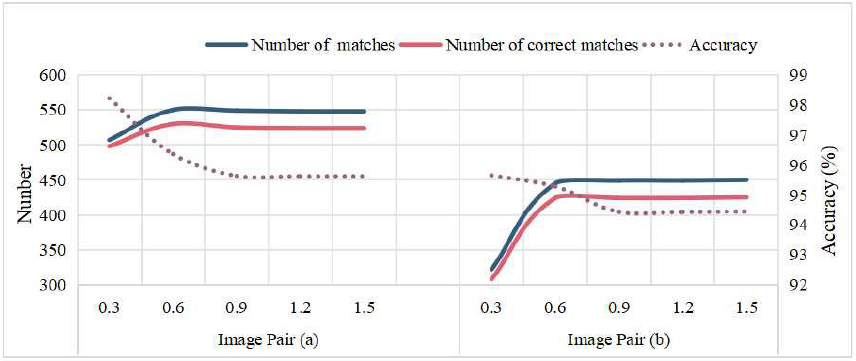
T for Figure 7a,b image pairs d